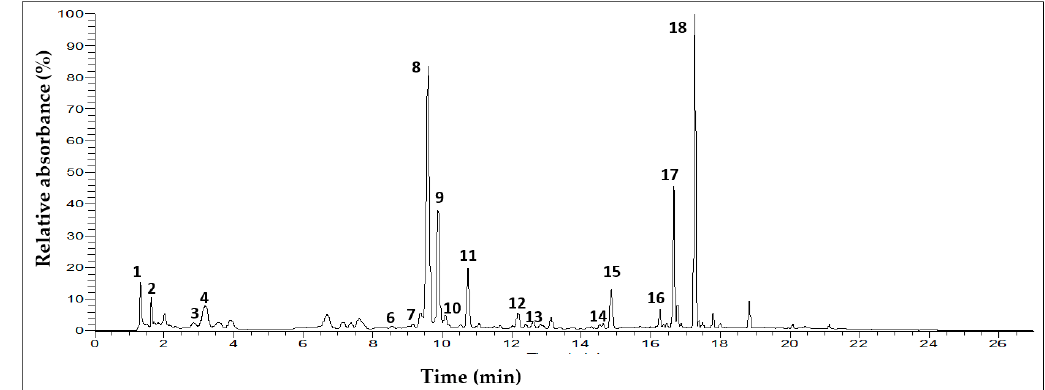
Figure 1. Chromatographic representation of Ta 12 population at 280 nm. Numbers in the figure correspond to the UHPLC-DAD-ESI-MS n peaks described in Table 3.